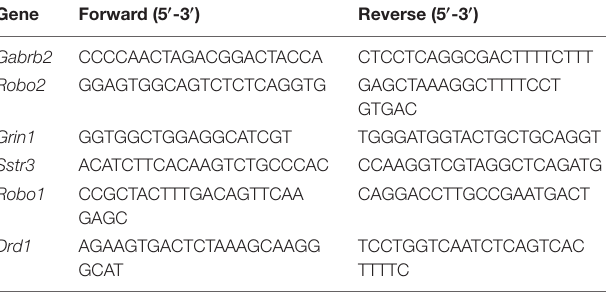
TABLE 2 | List of primers for qPCR of mouse samples.